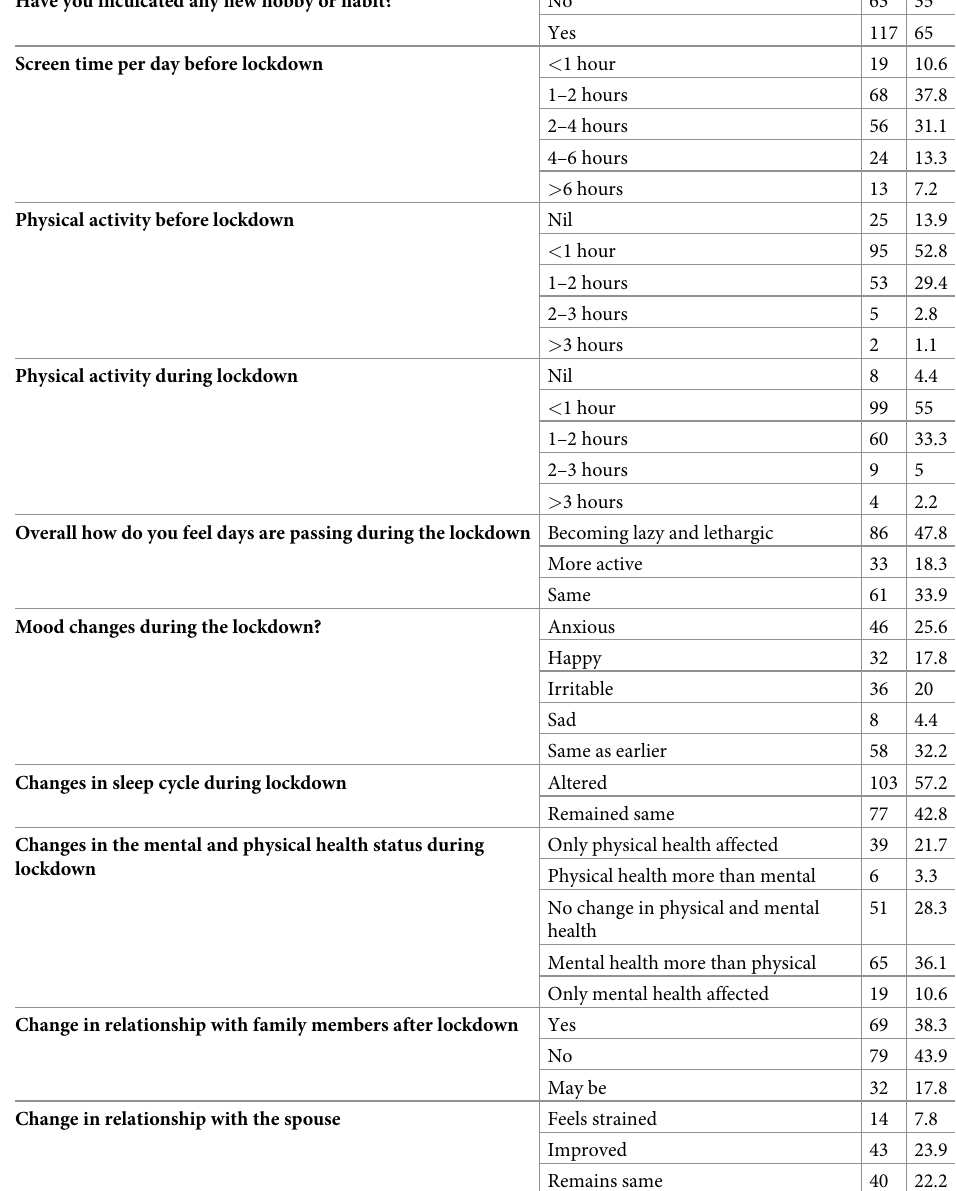
Table 2. Effect of Lockdown on their regular activities, physical and mental health, and relationship. Have you inculcated any new hobby or